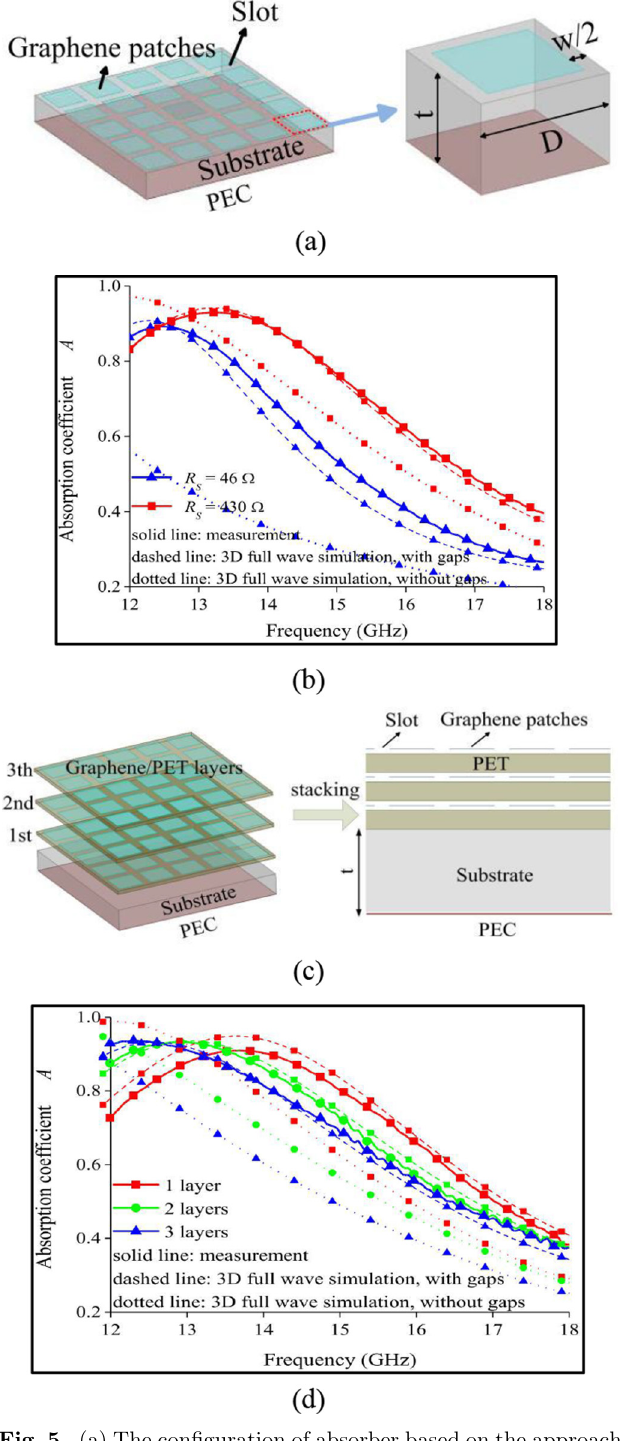
Fig. 5. (a) The con fi guration of absorber based on the approach of tuning surface resistance (TSR) and its unit cell. (b) Measured and simulated absorption coef fi cients of the TSR absorber under the different surface impedance of graphene. (c) The con fi gura- tion of absorber based on the approach of stacking graphene metasurface (SGM). (d) Measured and simulated absorption coef fi cients of the SGM absorber when stacking 1, 2 and 3 graphene fi